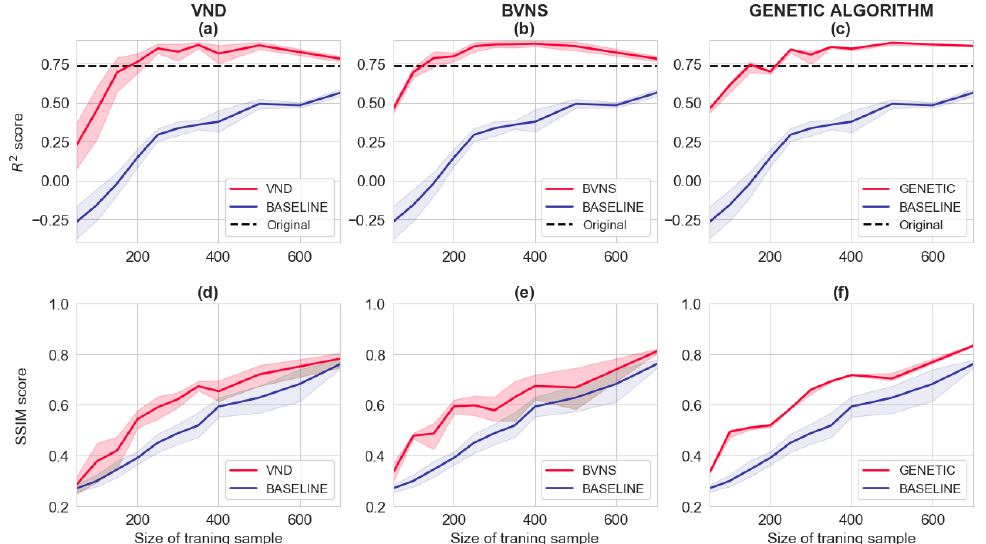
Figure 5. The performance of algorithms compared by R 2 score ( a – c ) and SSIM score ( d – f ) against the size of the training sample. Red lines correspond to the algorithms, and blue lines stand for the baseline. The black line shows the score on full training data. All the considered algorithms outperforms the baseline both by R 2 and SSIM , BVNS shows the best